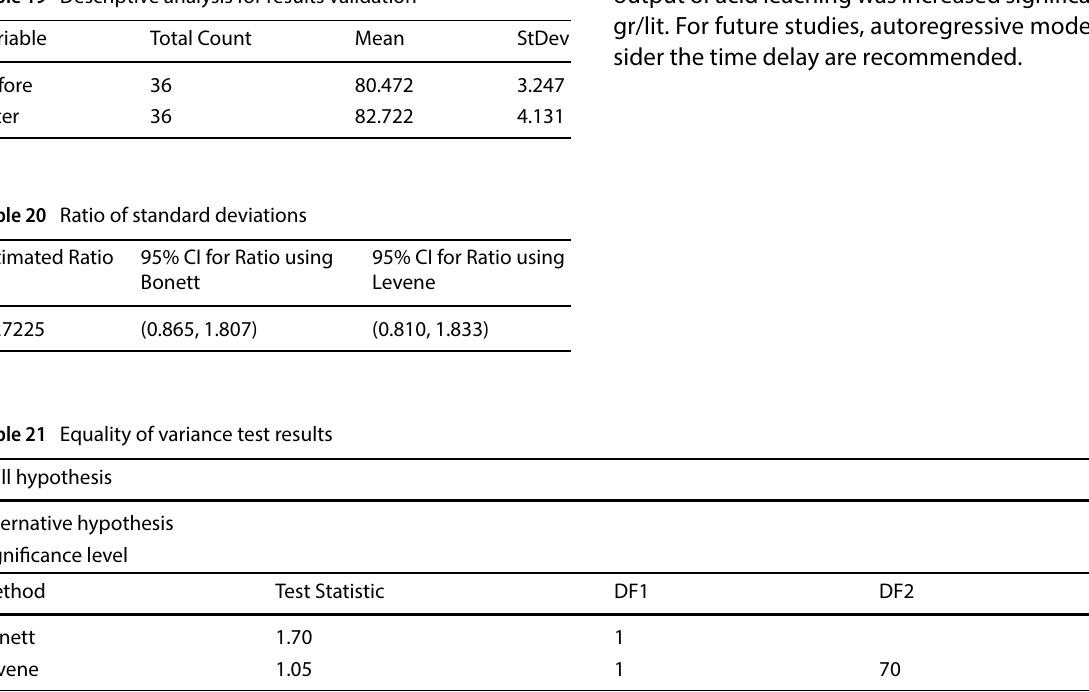
Table 19 Descriptive analysis for results validation